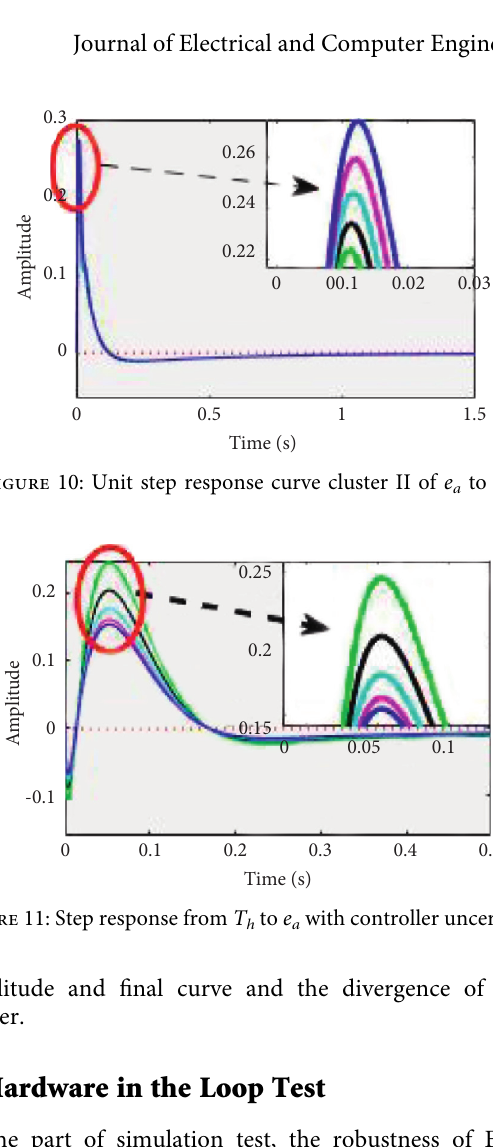
Figure 11: Step response from T h to e a with controller uncertainty.